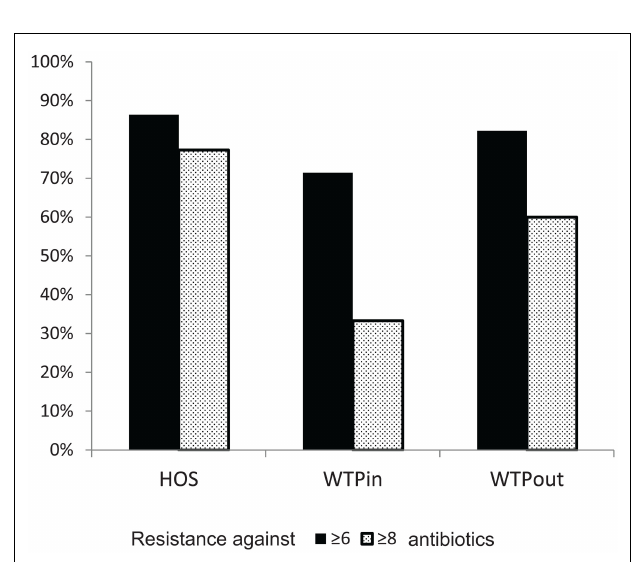
FIGURE 6 | Comparison of percentages of bacteria inheriting more than six (“highly multiresistant”) and more than eight resistances (“extremely multiresistant”) at the three sampling sites HOS,WTPin,